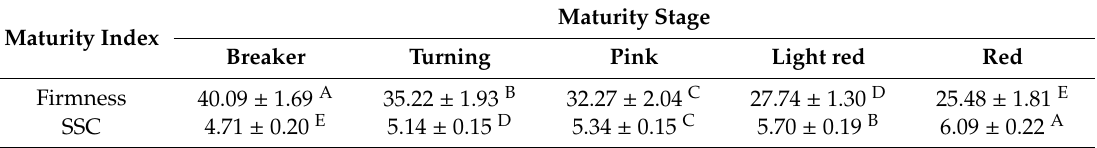
Table 1. Statistical analysis of firmness and soluble solid content (SSC) maturity indices a